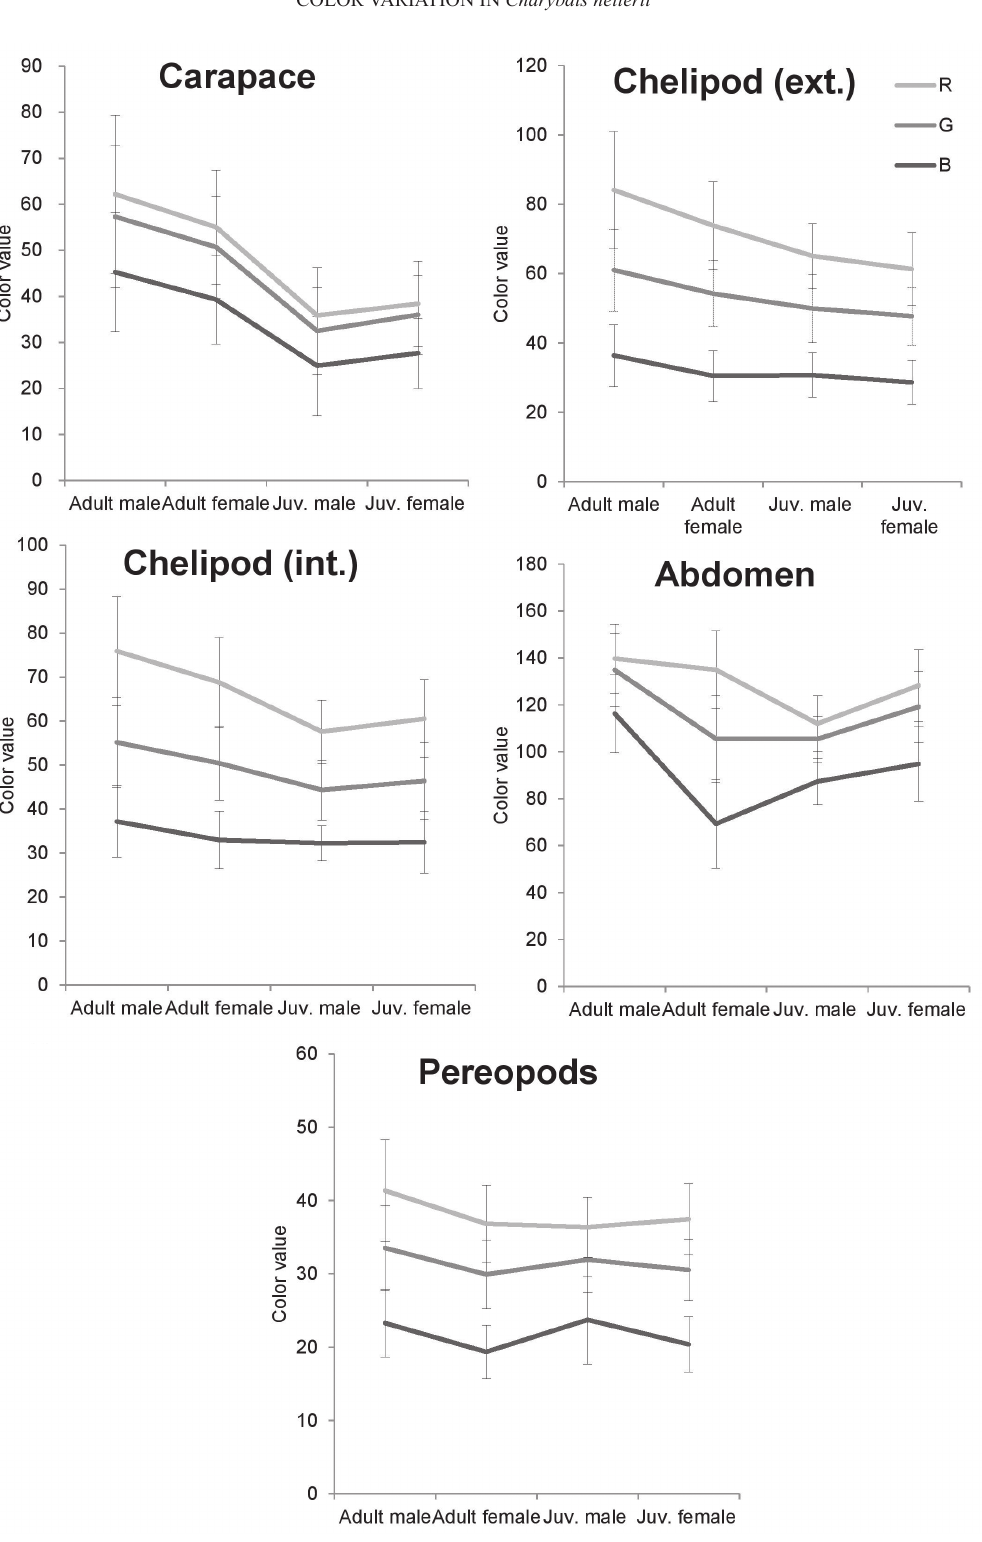
Figure 2 - Mean and standard deviation of color values (red, green and blue) for body structures of Charybdis hellerii (Maximum color value: 255). External surface=ext.; Internal surface=int.;